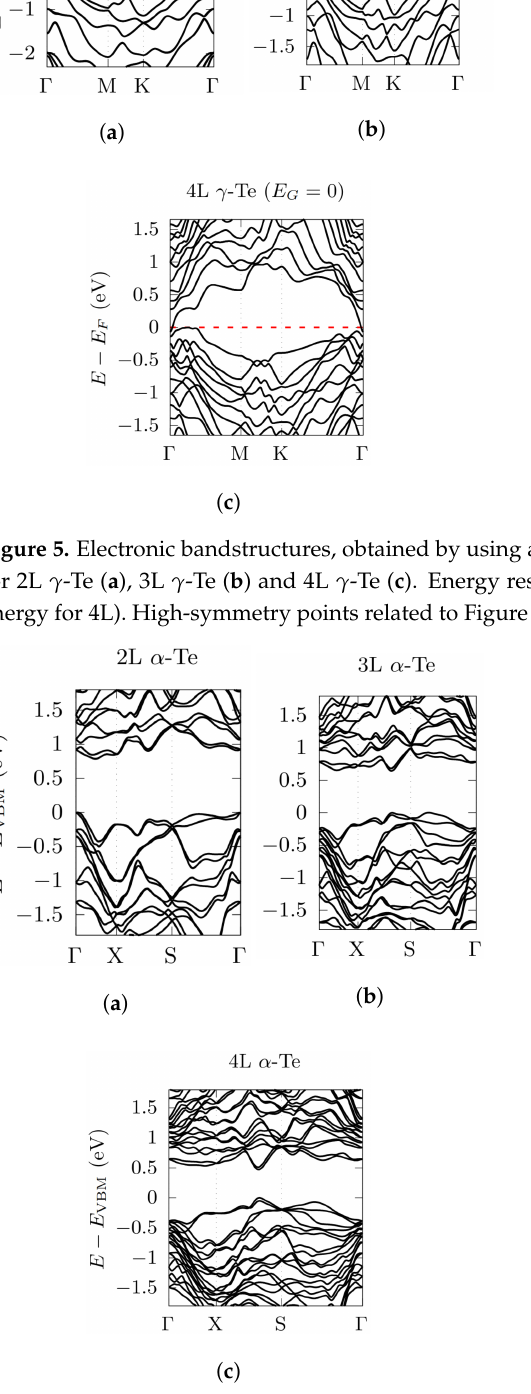
Figure 6. Electronic bandstructures, obtained by using a PBE functional, with the inclusion of SOC, for 2L α -Te ( a ), 3L α -Te ( b ) and 4L α -Te ( c ). Energy rescaled with respect to the VBM. High-symmetry points related to Figure 3 (orthorhombic BZ). Note that lower values of the gaps were found out of high-symmetry directions and they are reported in Table